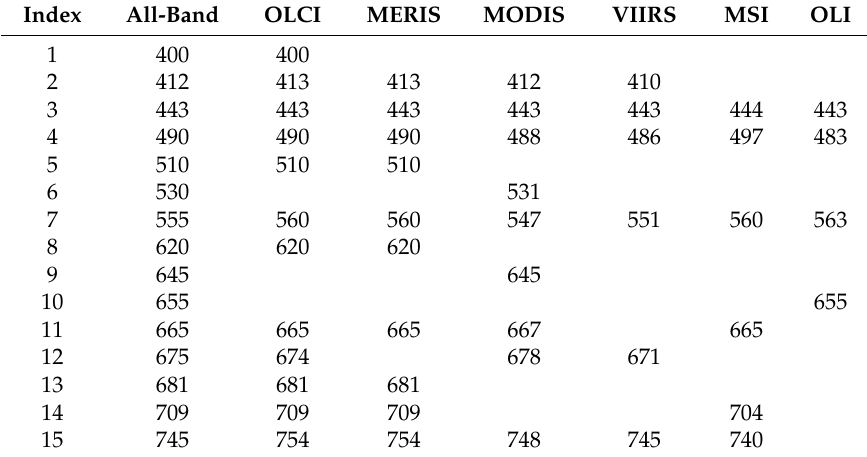
Table 4. The multi-spectral bands used in this study: a composed All-band, OLCI, MERIS, MODIS, VIIRS, MSI and OLI